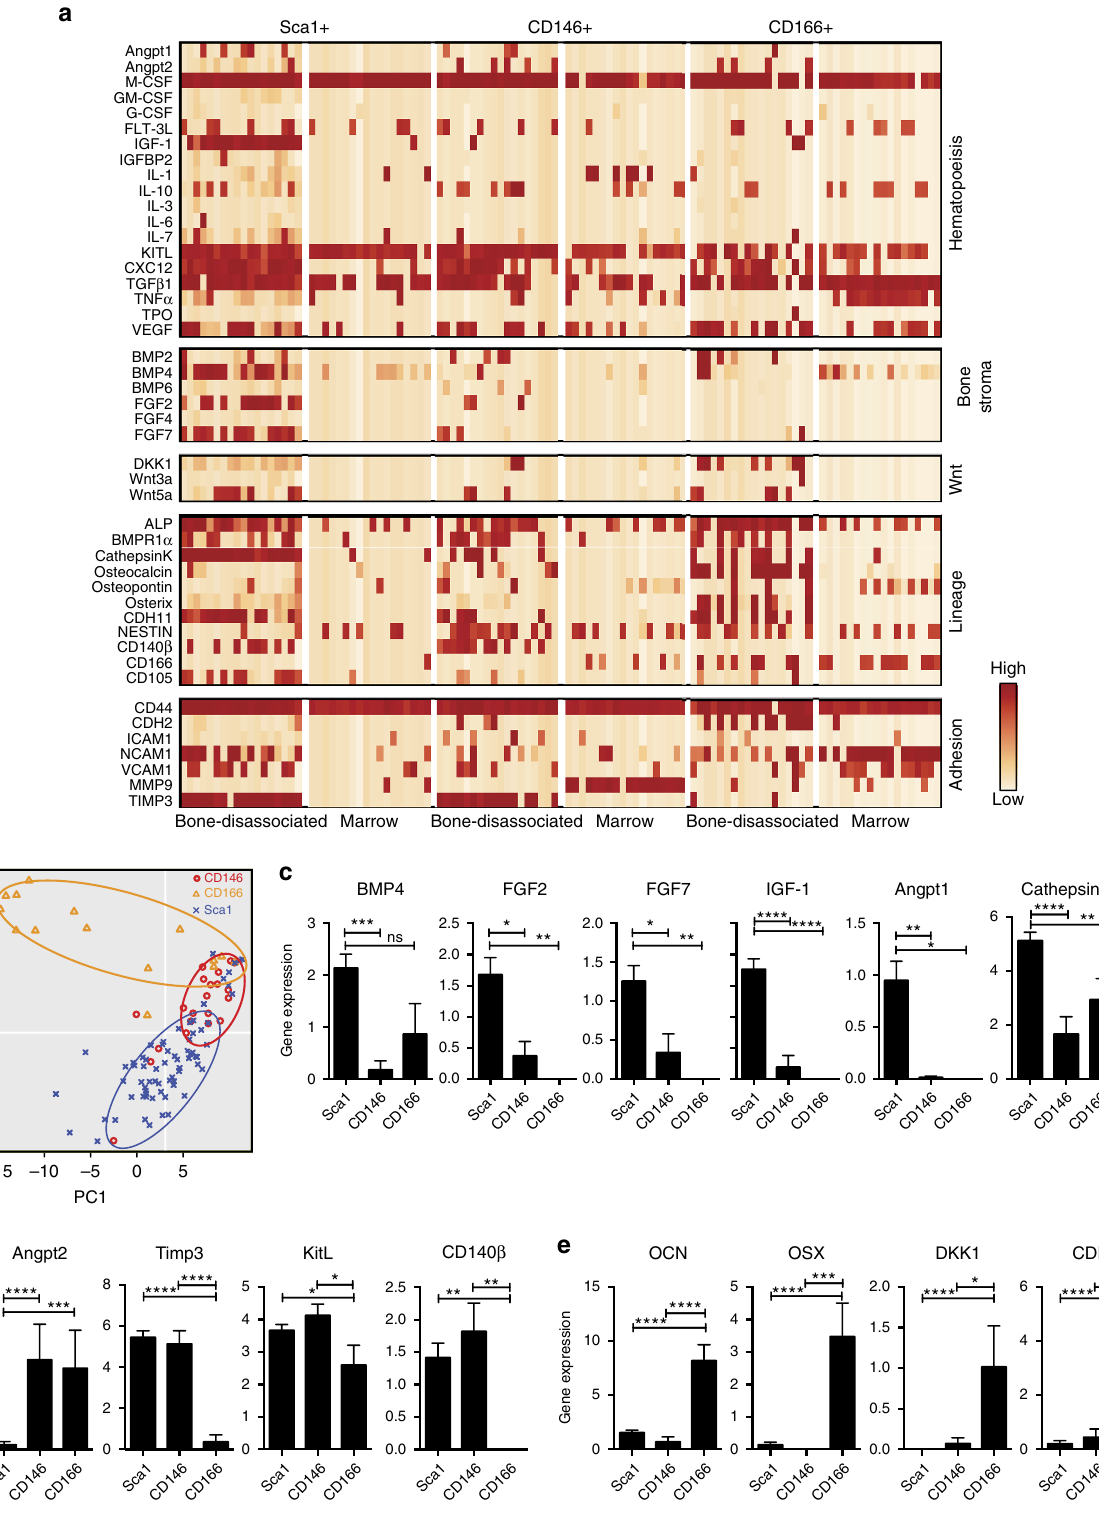
Figure 5 | Bone-disassociated mesenchymal progenitors and marrow stromal cells possess different gene expression profiles. ( a ) Representative qRT-PCR of 18 single cells from CD146 þ , CD166 þ or Sca1 þ stromal populations either near the endosteum (bone-disassociated) or in the marrow (Marrow) using the Fluidigm 48.48 dynamic array. Each column within a given population represents expression in an individual cell. ( b ) Comparison of the first and second prinicpal components from a principal component analysis of single-cell PCR gene expression data from all 47 genes. ( c – e ) Expression patterns of genes that are significantly overexpressed in mean ± s.d. ( c ) Sca1 þ cells ( d ) Sca1 þ cells and/or CD146 þ cells, or ( e ) CD166 þ cells. Statistical significance was calculated using one-way ANOVA analysis * P r 0.05, ** P r 0.005, *** P r 0.00; n ¼ 72. ANOVA, analysis of